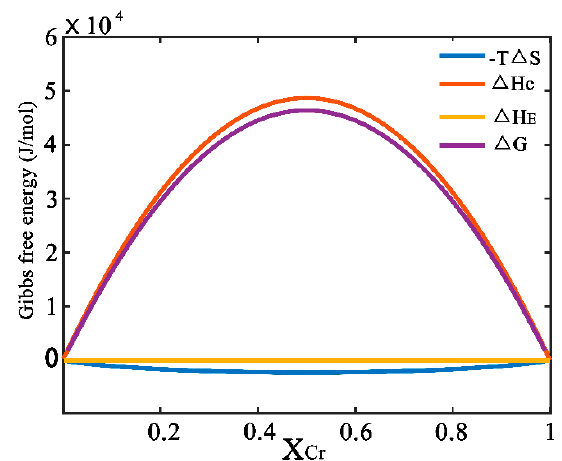
Figure 2. Enthalpy, entropy and Gibbs free energy of the Cu-Cr system at the temperature of 473 K.